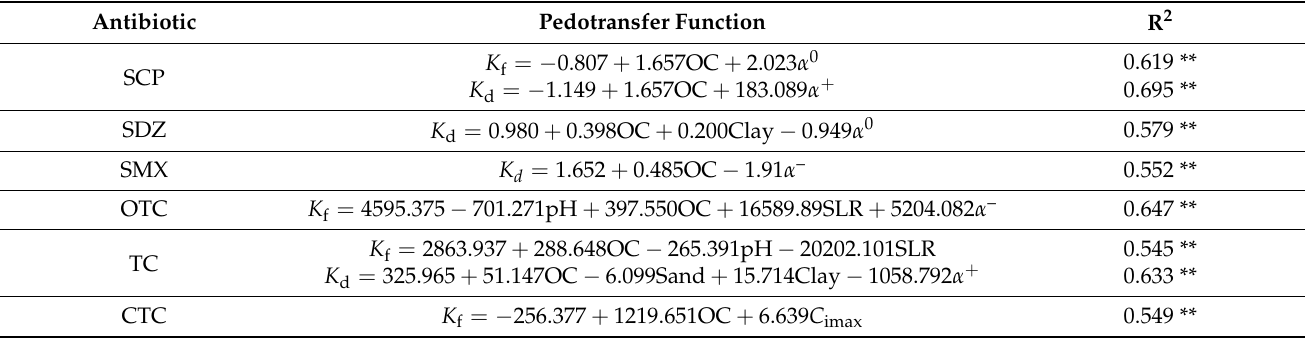
Table 5. Improved models by inclusion of additional independent variable(s) for estimating K f and K d of antibiotics in soils (based on sub-datasets “A” and “B”). Antibiotic Pedotransfer Function R 2